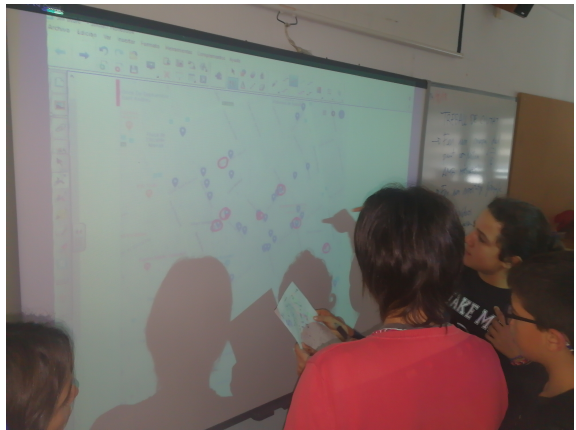
Figure 3. Identifying danger points in the surroundings of the